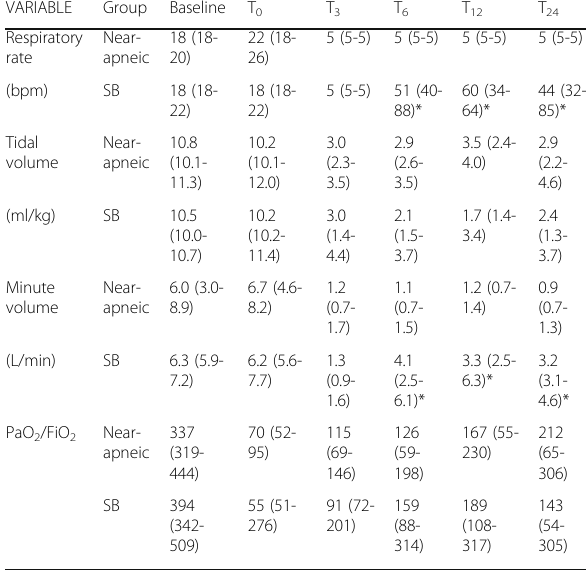
Table 1 (abstract 0436). Respiratory variables. Values are expressed as median (range). *p<0.05 comparing groups